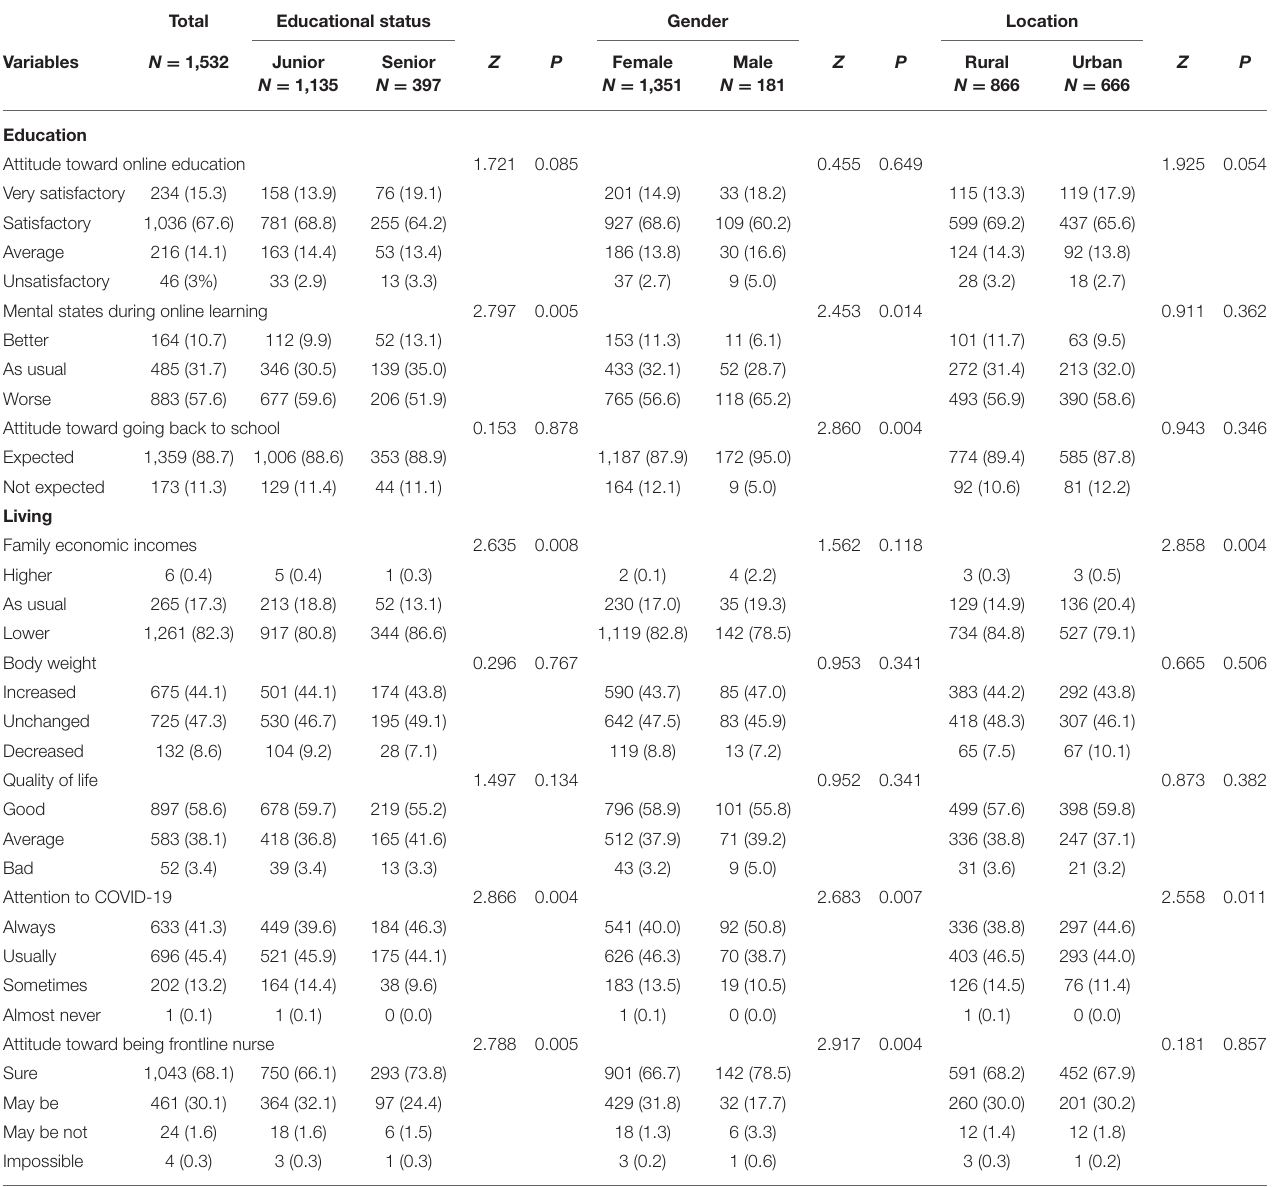
TABLE 1 | Educational and living conditions of all and subgroup